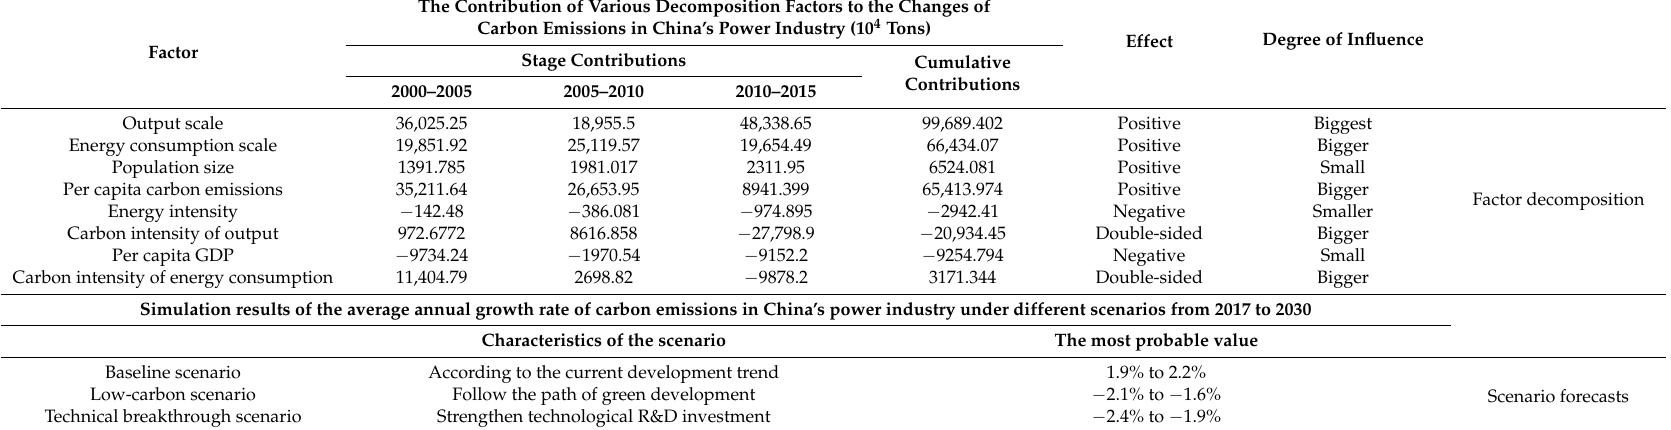
Table 7. Main conclusions of this